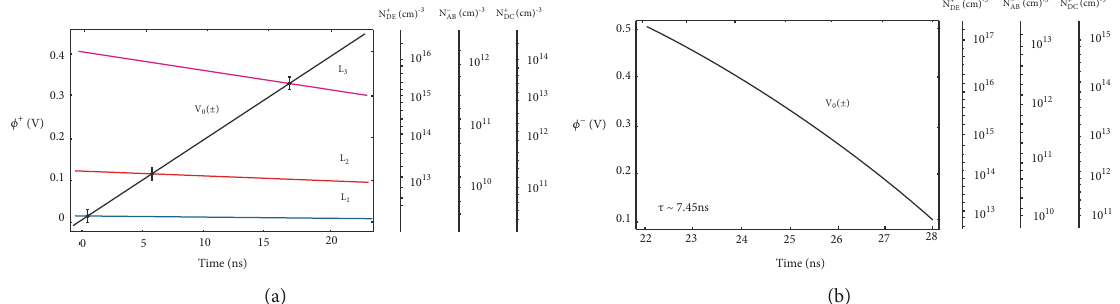
Figure 6: Dynamical behavior of the transistor action at 𝐼 𝐶 = 60𝑚𝐴 and 𝑉 𝐵𝐸 = 0.75𝑉 .